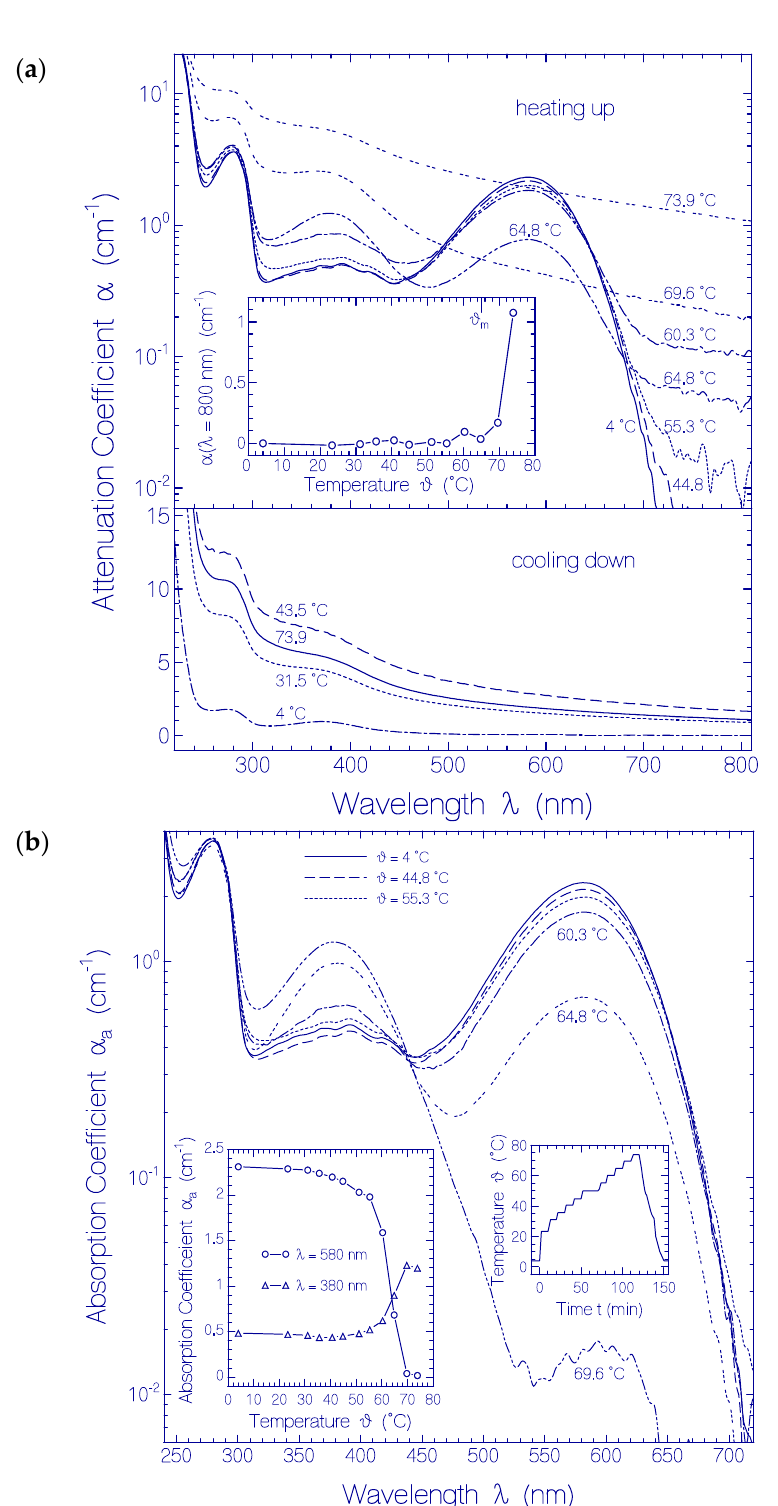
Figure 4. Heating-cooling cycle behavior of a fresh thawed QuasAr1 sample in pH 8 Tris buffer. ( a ) Attenuation coefficient spectra α ( λ ) development during stepwise sample heating up (top part) and cooling down (bottom part). Inset in top part: Temperature dependent attenuation coefficient development α (800 nm) during sample heating up. ( b ) Absorption coefficient spectra α a ( λ ) development during stepwise sample heating up. Left inset: Temperature dependent absorption coefficient development α a (580 nm) and α a (380 nm). Right inset: Applied heating and cooling temperature profile ϑ ( t